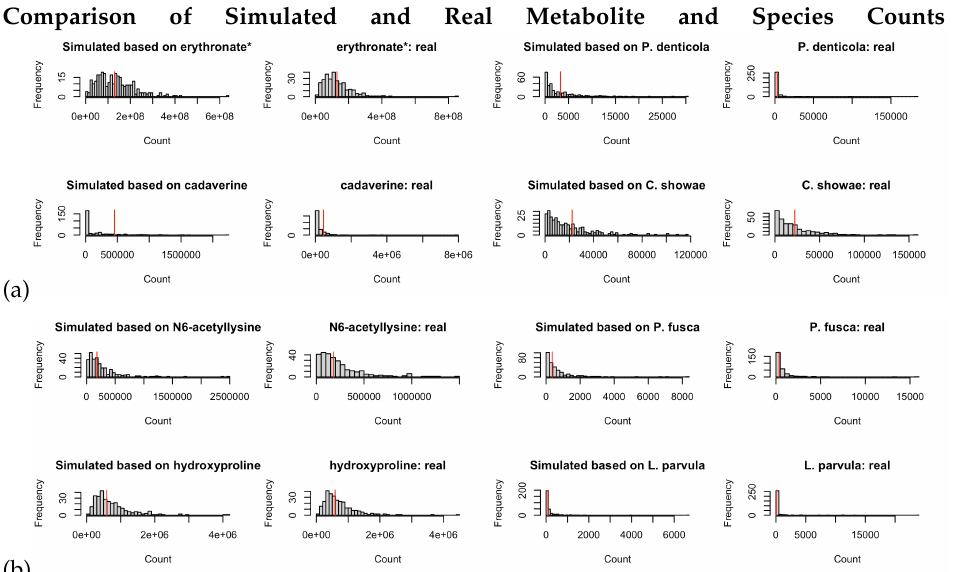
Figure A1. Evaluation of goodness-of-fit for the ZINB/NB and lognormal models by comparing the histogram of frequency between the simulated data and real data processed in Kraken2/Bracken. The 2nd and 4th columns each contain one species or metabolite from ZOE 2.0. The 1st and 3rd columns contain ZINB simulated data using the parameters estimated from the corresponding species. The 1st and 2nd columns illustrate metabolites, and the 3rd and 4th columns present microbial species. The star at the end of some of the metabolite names indicates that Metabolon, where the metabolome data were generated, is confident in the metabolite’s identity but it has not been confirmed based on a standard. ( a ) denotes ZINB/NB-based simulation, and ( b ) denotes ZILN/lognormal based simulation.